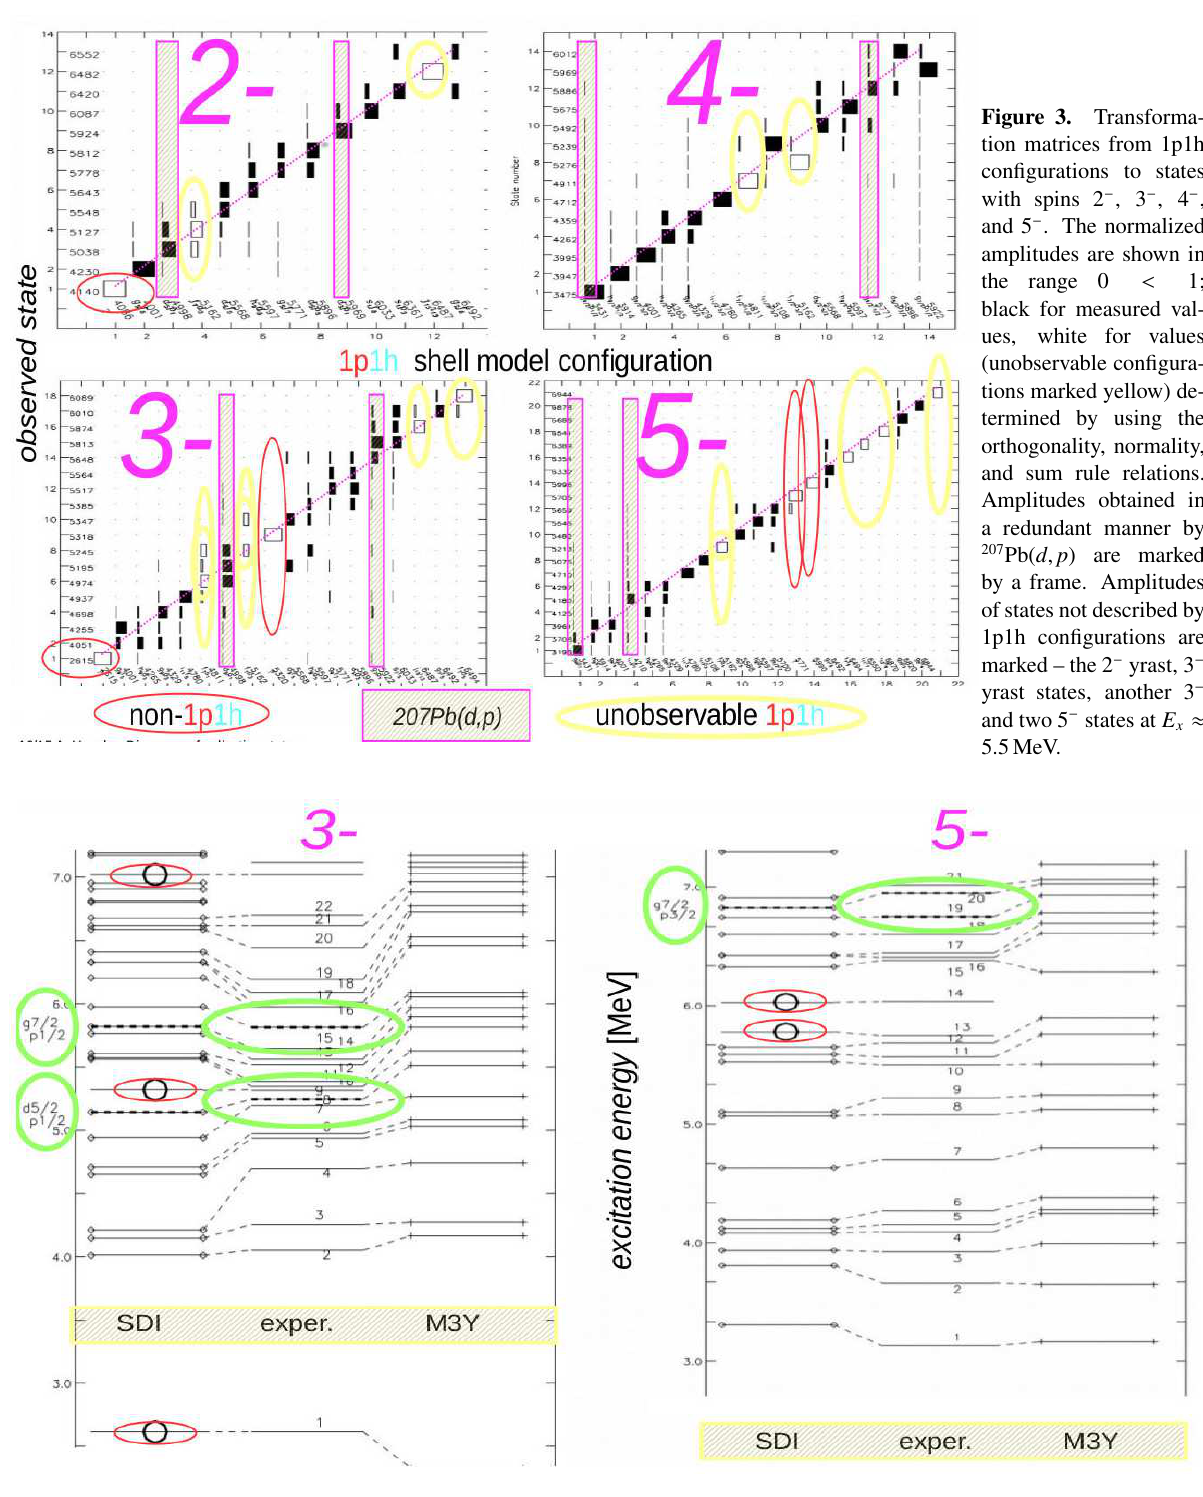
Figure 4. Comparison of level schemes for the 3 − and 5 − states at E x < 7 . 2MeV to shell model calculations with SDI [12] and M3Y [13]. Three 3 − and two 5 − states are not easily explained with M3Y by 1p1h configurations and with SDI not at